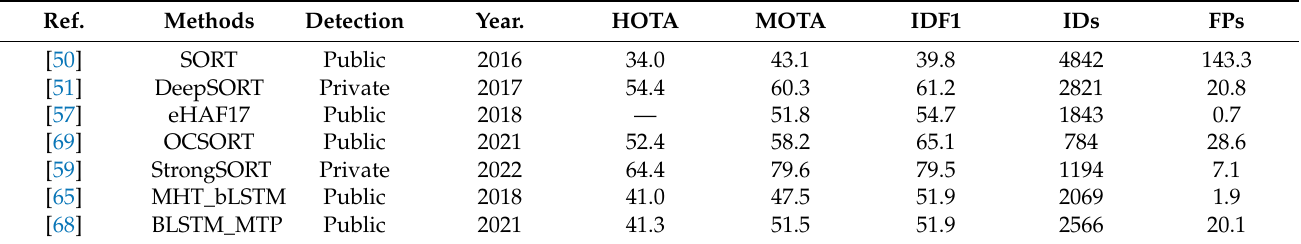
Table 4. The tracking results of the algorithm based on the TBD framework on the MOT17 test set [25].